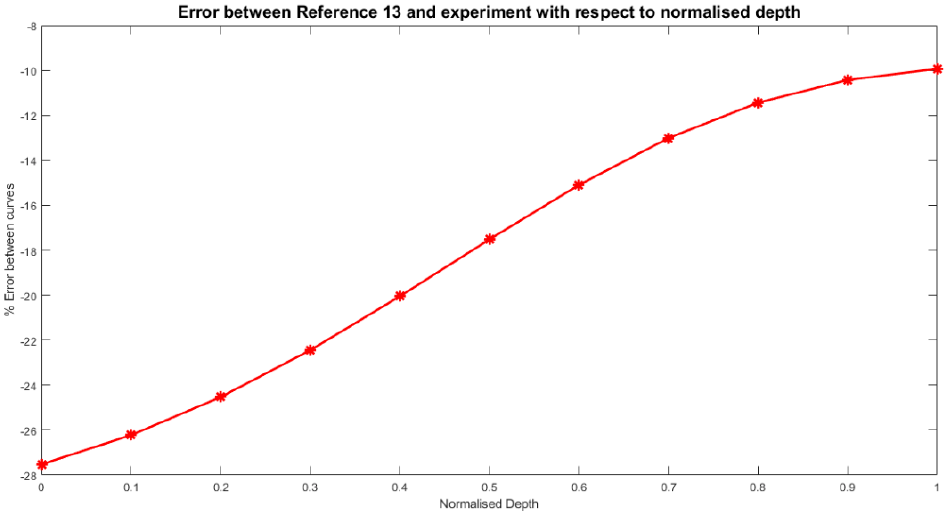
Figure 16. Variation of errors between reference 13 and field experiment corrosion rates with respect to normalised depth.